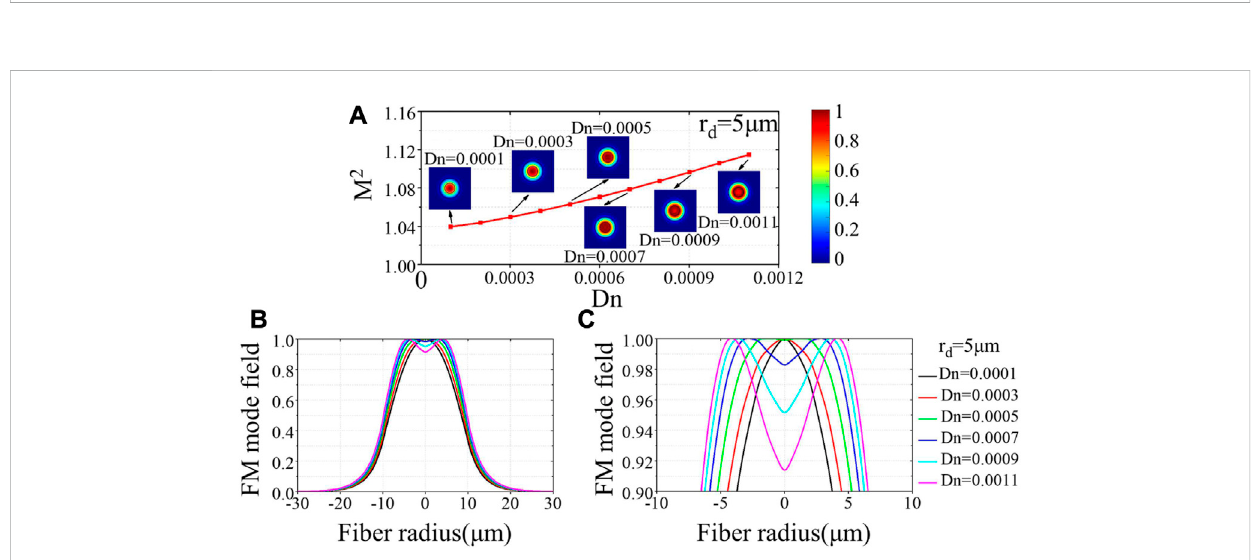
FIGURE 4 (A) TheoreticalcalculatedbeamqualityM 2 underdifferentdipdepths.Insetsshowthe2D fi eldintensitydistribution. (B) Evolutionof fi elddistribution under different dip depths. (C) Magni fi ed fi eld distribution in fi ber core under different dip